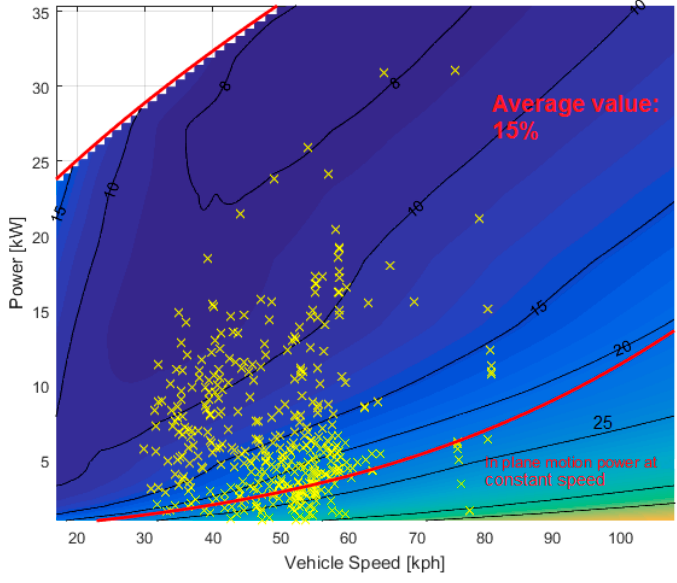
Figure 14. Extra-urban mission work points on the electrical-loss (%) contour map.